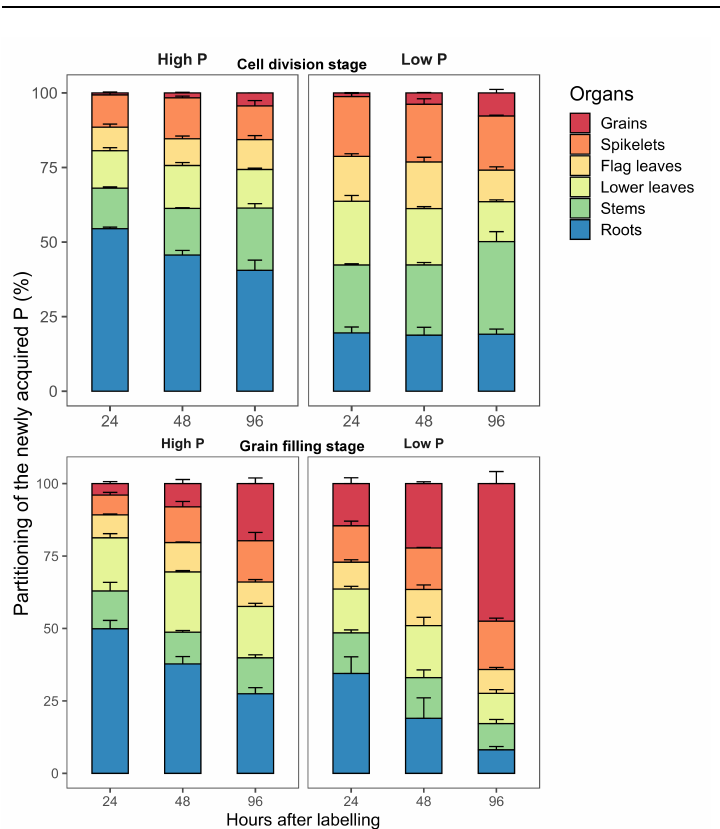
Figure 3. The partitioning of the newly acquired P in different durum wheat organs (grains, spikelets, flag leaves, lower leaves, stems, and roots) following 32 P labeling at the cell division stage and grain filling stage. Values are the mean ± standard error of three replicates. Plants were grown in a hydroponic culture with high or low P supply. Each labeling experiment lasted 24